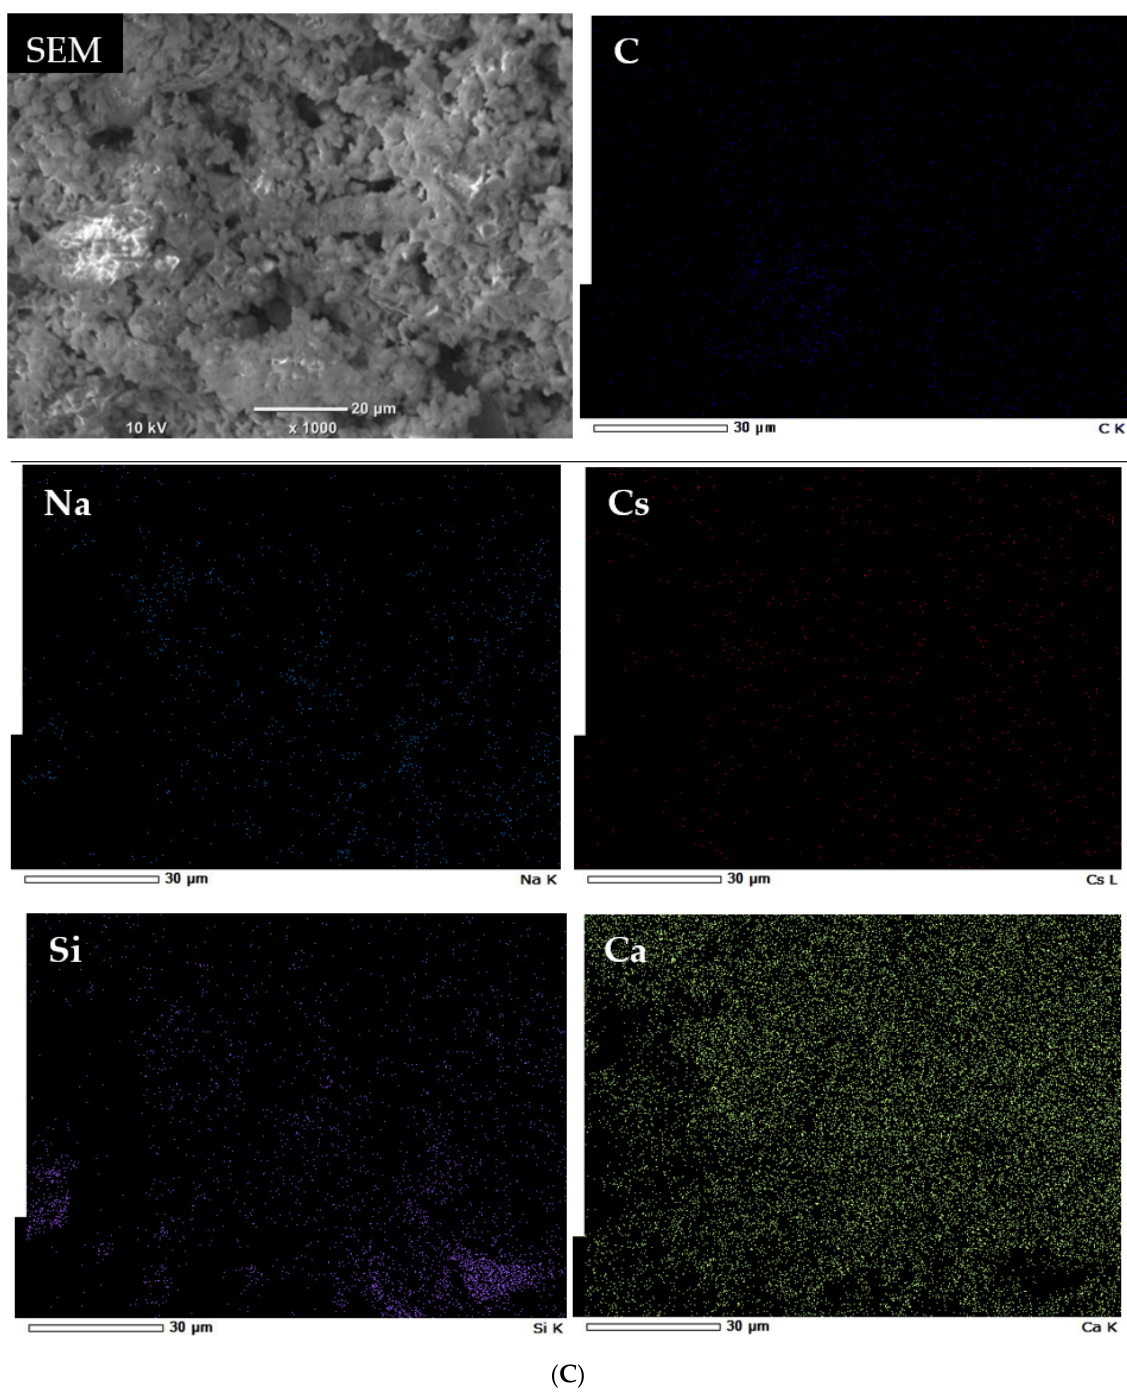
Figure 5. SEM and element mapping images of the geomaterial matrices. ( A ) Portland cement, ( B ) fly ash, ( C ) slag. The specific surface areas of ordinary Portland cement, fly ash-based geomaterials, and slag-based geomaterials were measured by N 2 adsorption. The pore characteristics of the powder binder determined by the BET method are summarized in Table 2. These results indicate that the fly ash-based geomaterials had the highest surface area and micropore volume and that the pore characteristics of the fly ash-based geomaterials were the most suitable for the adsorption of Cs, which is consistent with the SEM results. This also indicates that fly ash-based geomaterials may be the most effective in terms of chemical barriers to prevent the release of cesium.